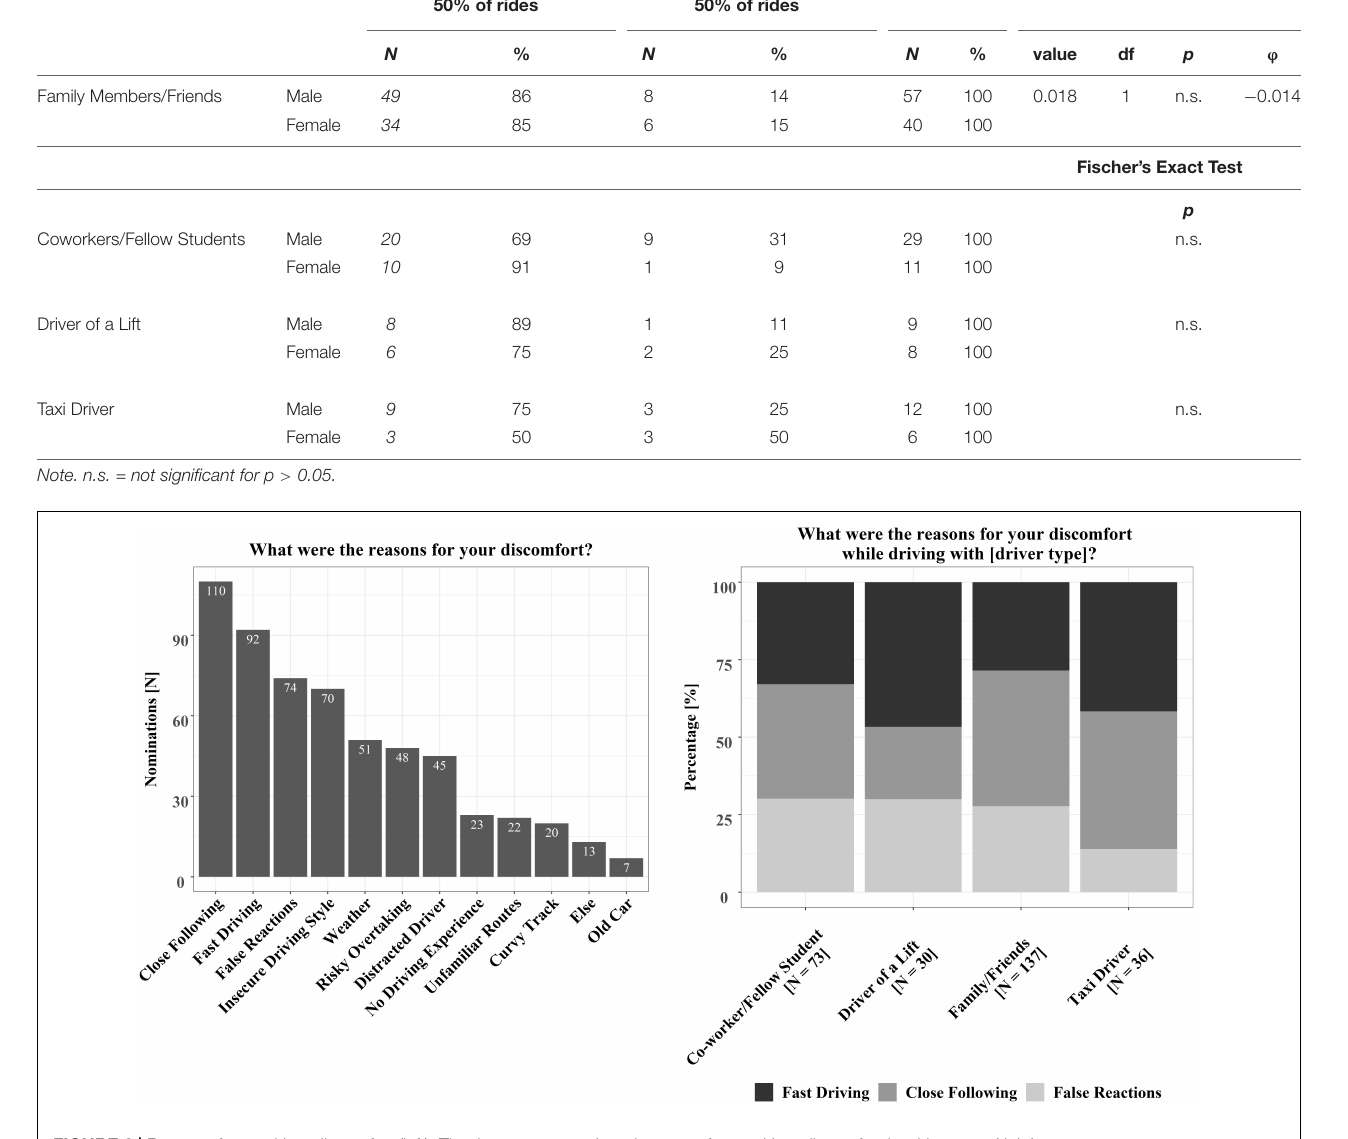
Discomfort in more than 50% of rides 50% of